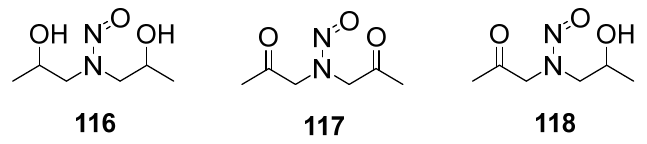
Figure 9. Structures of NDPA analogs that form DNA